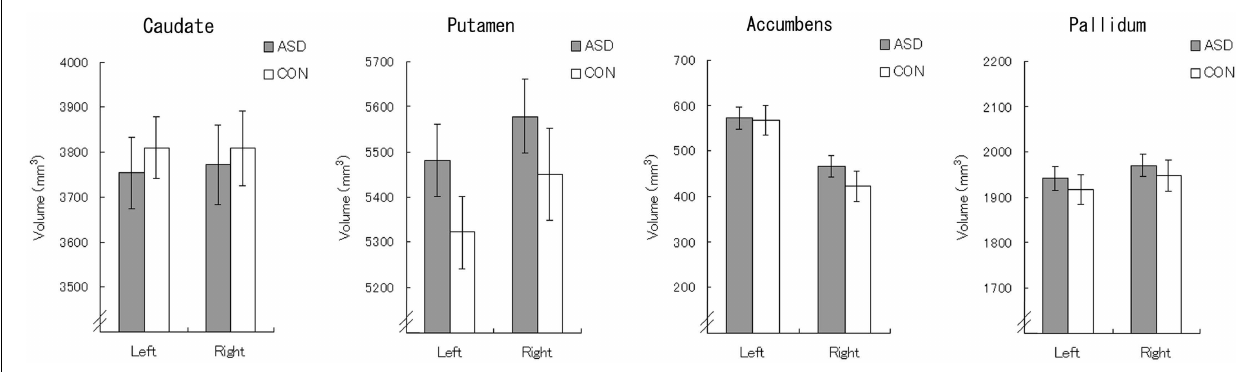
FIGURE 2 | Mean ( ± SEM) volumes of the caudate, putamen, globus pallidus, and nucleus accumbens . * p <